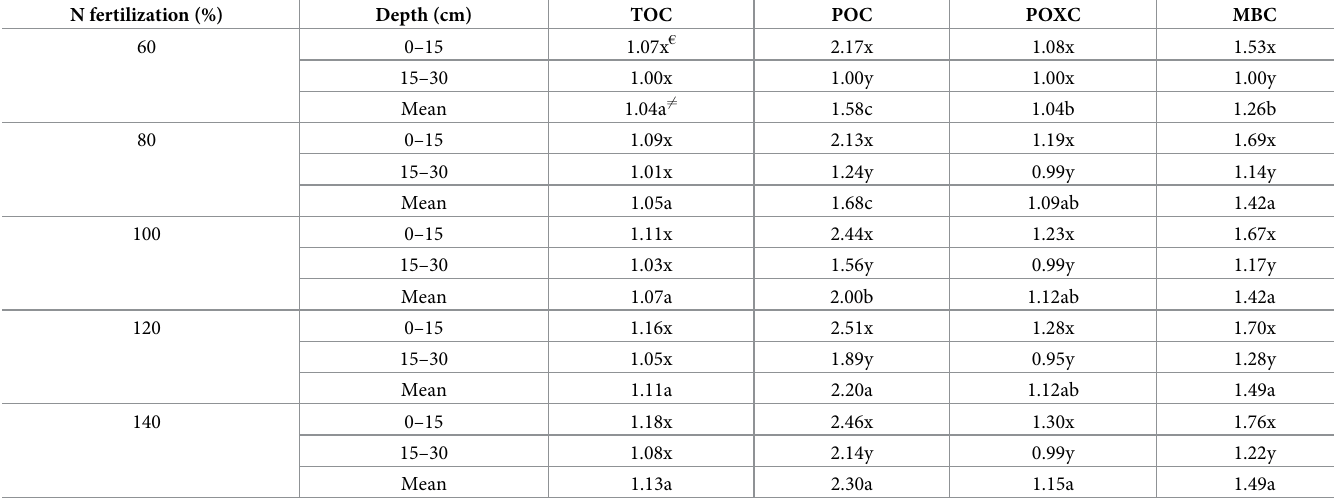
Table 4. Impact of nitrogen fertilization on stratification of total organic carbon, particulate organic matter, particulate organic carbon, and permanganate oxidiz- able carbon at different depths of soil. N fertilization (%)